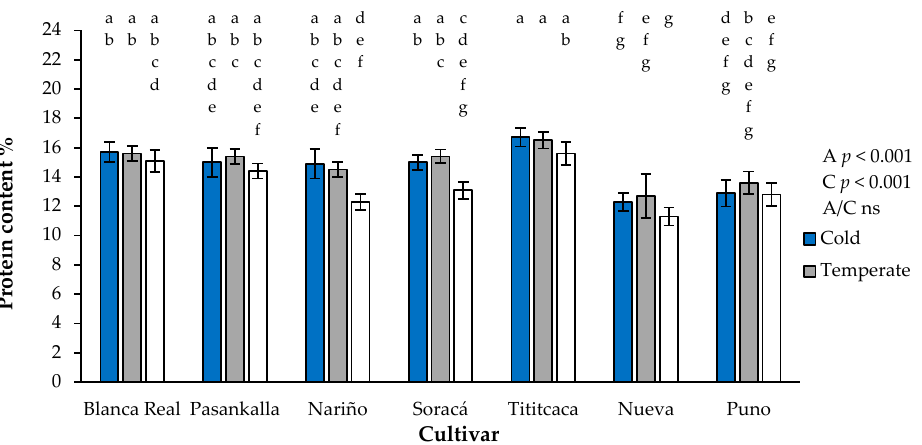
Figure 5. Protein content of different quinoa cultivars subjected to three altitudinal gradients. The bars indicate standard error. Different letters indicate significant differences. A: Altitudinal; C: Cultivar; A/C: Altitudinal/Cultivar.